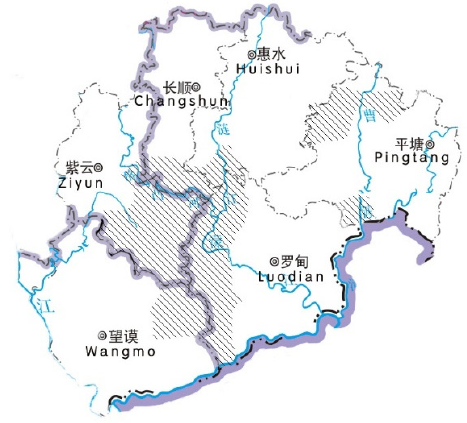
Figure 1. Range of the Mashan Region.